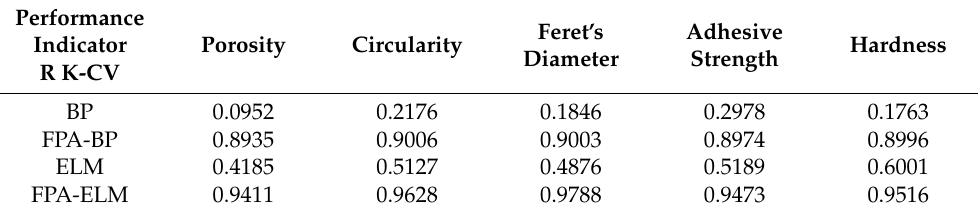
Table 2. The R prediction comparison results of the five parameters of the BP, FPA-BP, ELM and FPA-ELM model obtained by 6-fold CV.